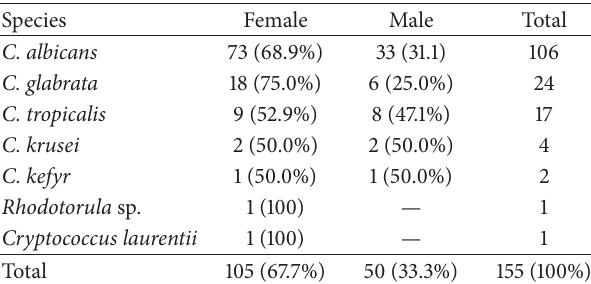
Table 3: Distribution of yeast isolates in relation to